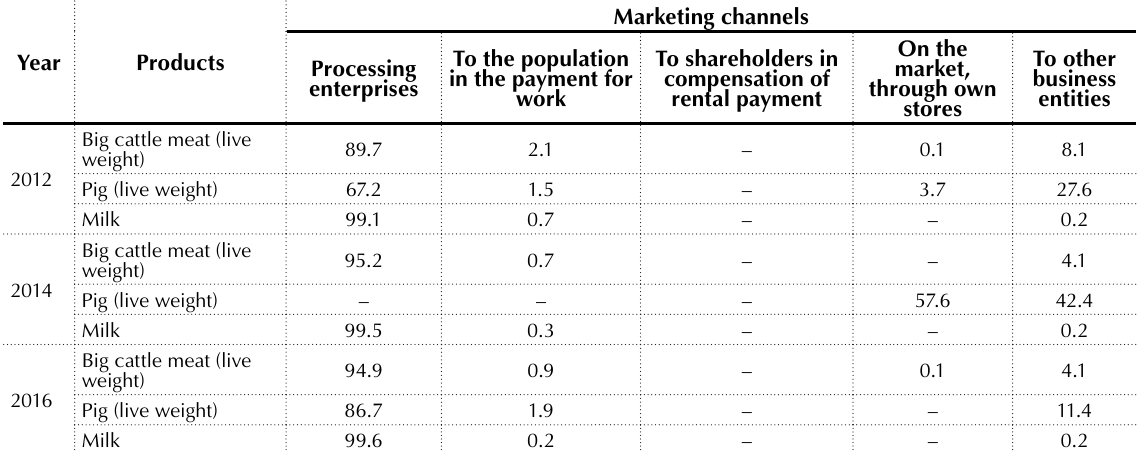
Table 6. The structure of livestock products sales channels by agricultural enterprises of Khrystynivka district, Cherkasy region